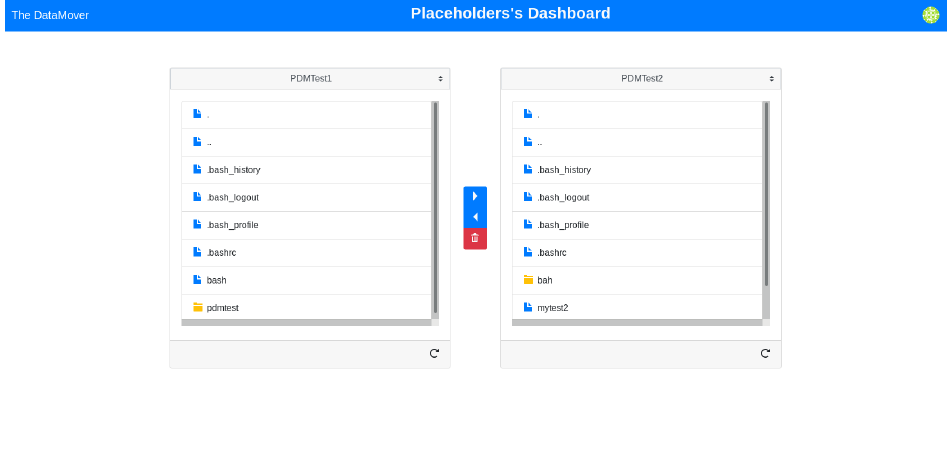
Figure 2. A screenshot of the user facing